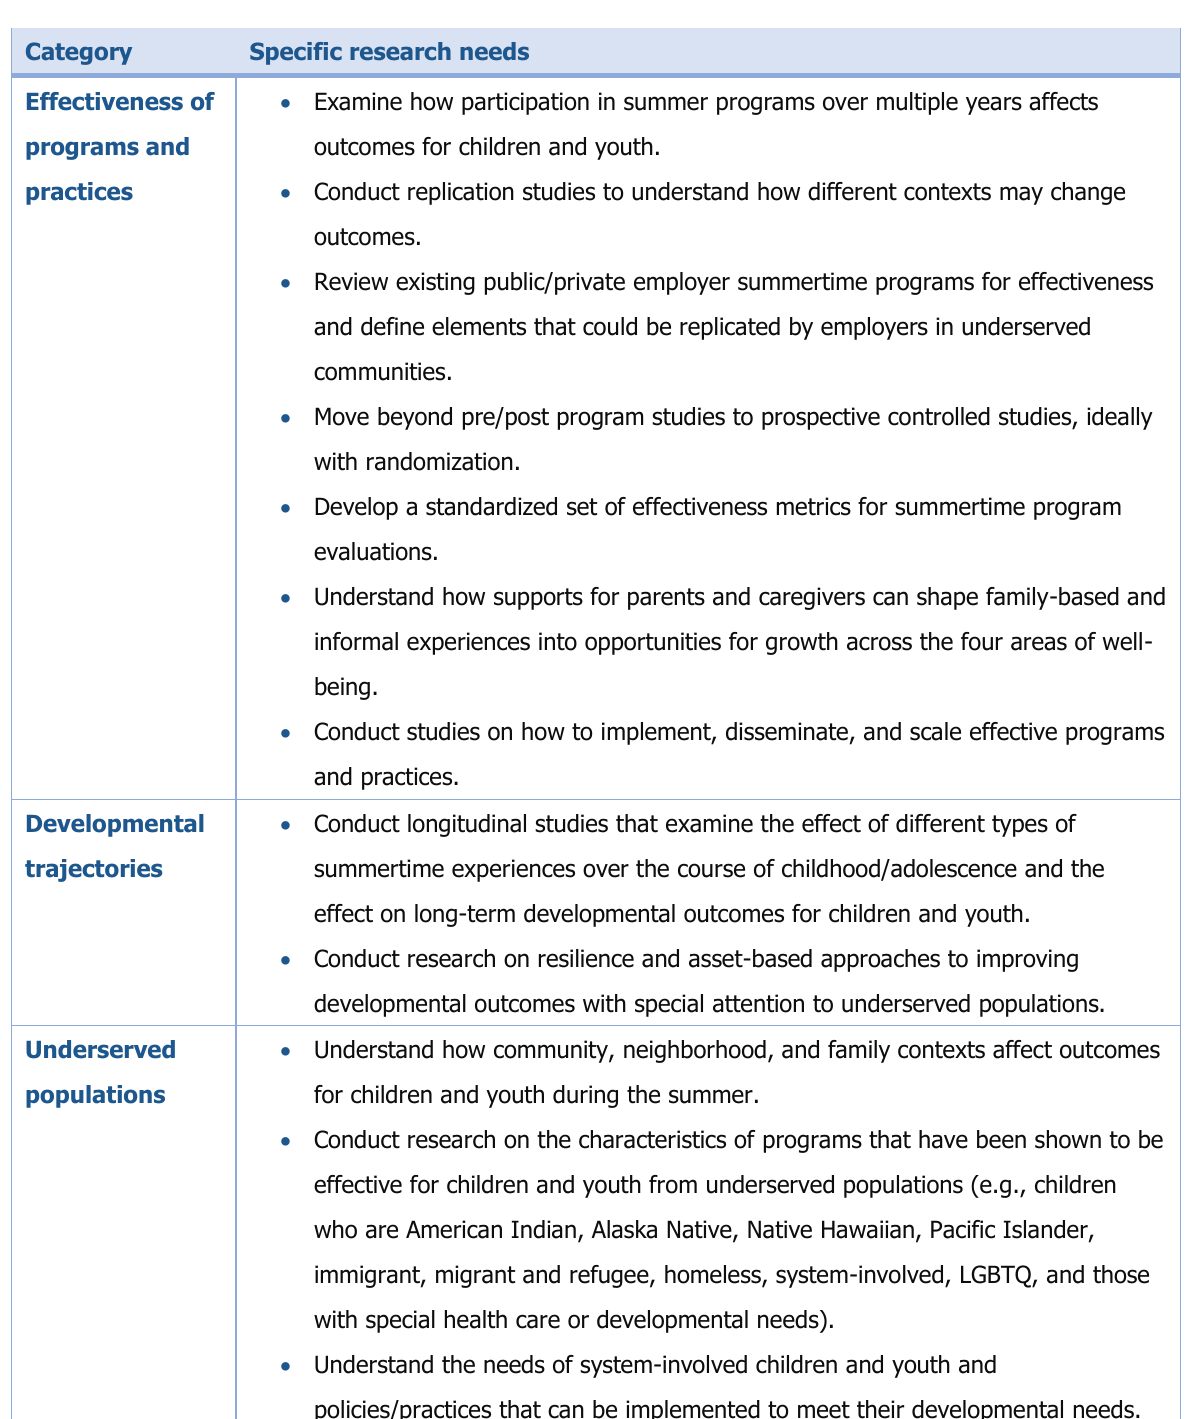
Table 1. Selected Research Needs to Inform Evidence-Based Summertime Programs and